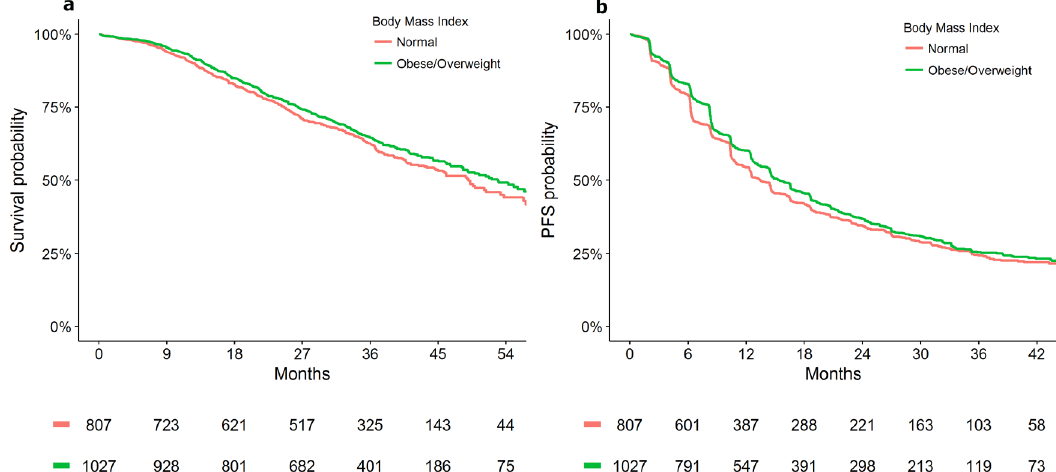
Fig. 2 Kaplan – Meier plot representing survival outcomes in the fi rst-line therapy cohort by BMI status in advanced breast cancer [Data from CLEOPATRA and MARIANNE study]. a Overall survival; b progression-free survival.